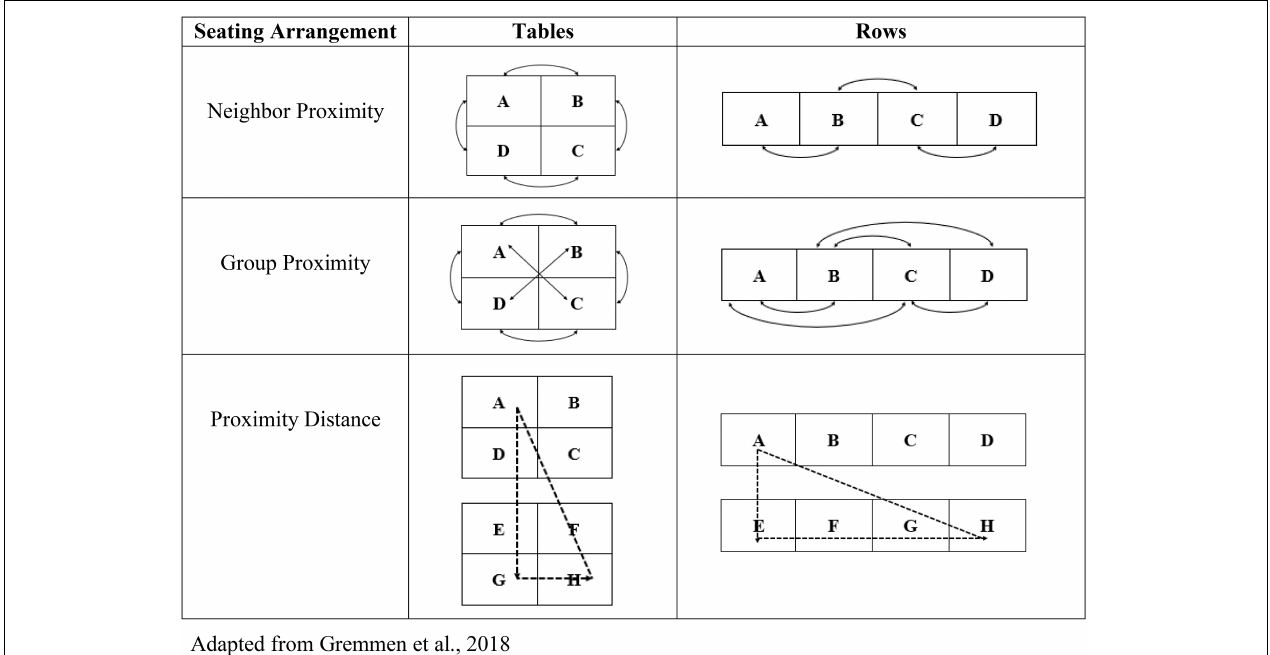
FIGURE 1 | Illustration of three forms of propinquity [adapted from Gremmen et al. (2018)].